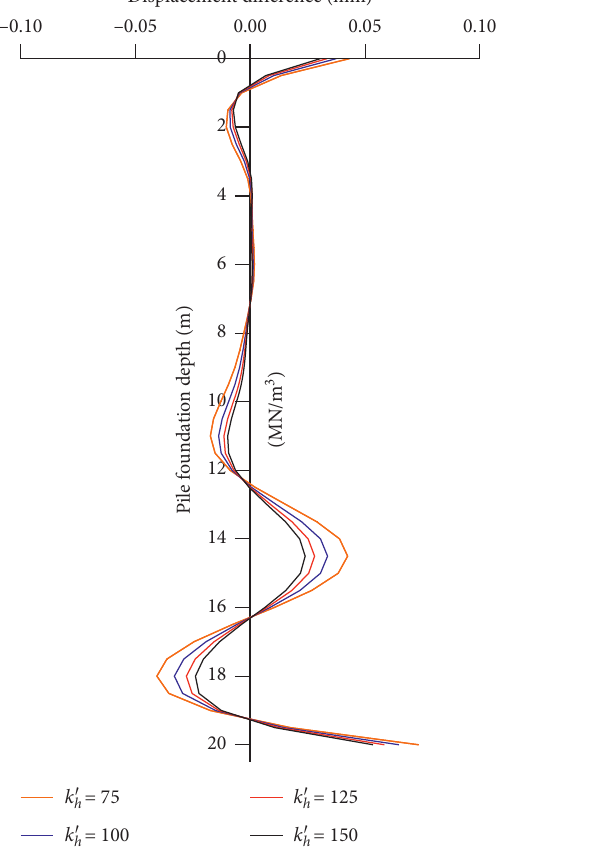
Figure 12: Relation between D and Δ s